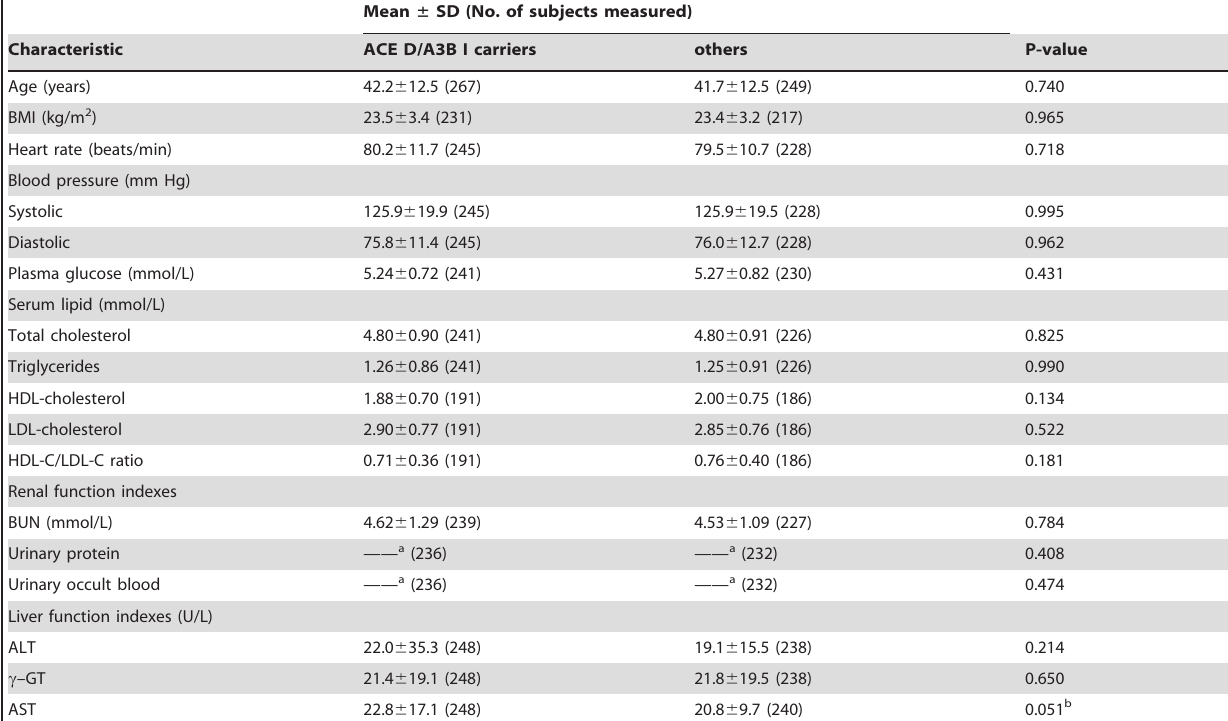
Table 4. Characteristics of female subjects grouped by ACE and A3B